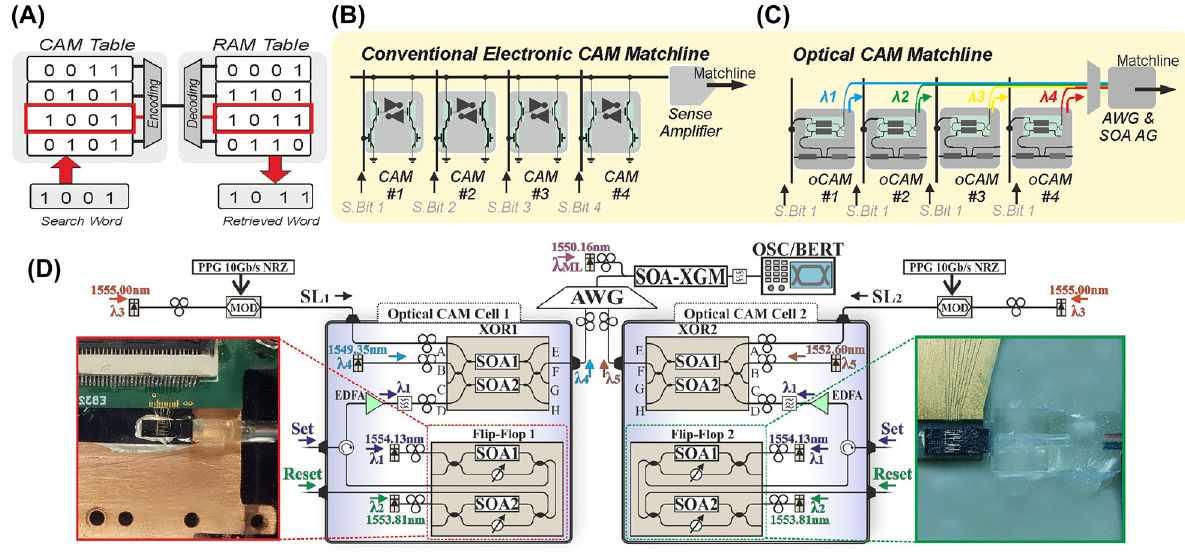
Figure13: Multicellarrayswithlookup tables.(A) Schematicdiagramof a look-upmemorytablearchitecture.(B)Layoutof conventional 4-bit electronic CAM Matchline layout. (C) Layout of a 4-bit optical CAM Matchline layout. (D) Experimental implementation of the first optical 2-bit CAM Matchine computing with photonic